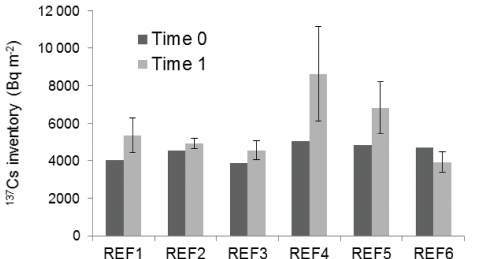
Figure 6. Temporal variation between the total 137 Cs inventories measured at the reference sites in the Urseren Valley; time 0 = 2013 and time 1 = 2015. The error bars indicate the standard deviations of the inventories among the replicates collected at each reference site in